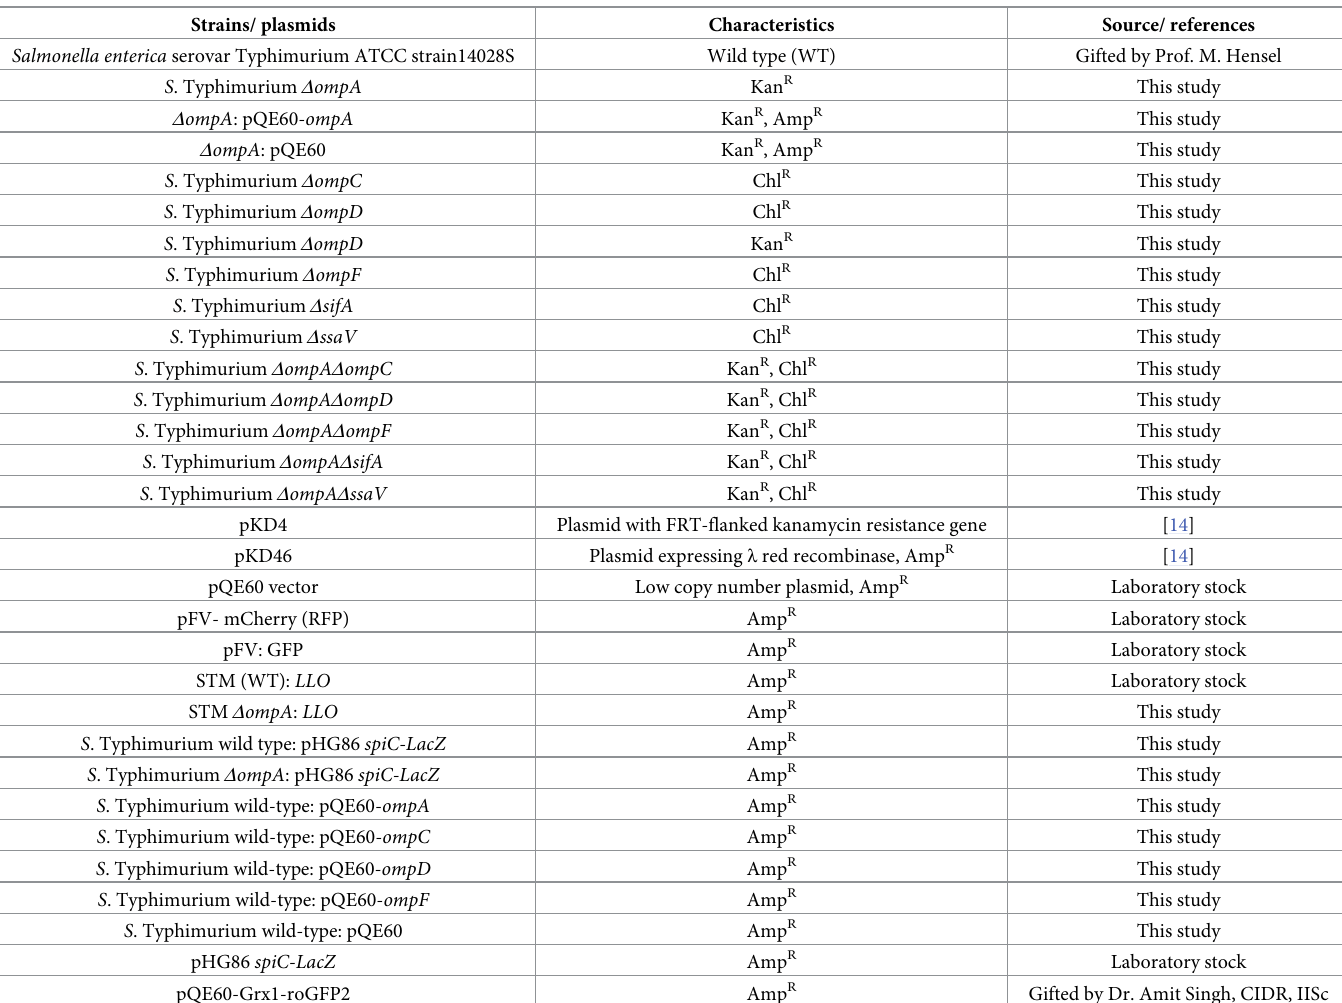
Table 1. Strains and plasmids used in this